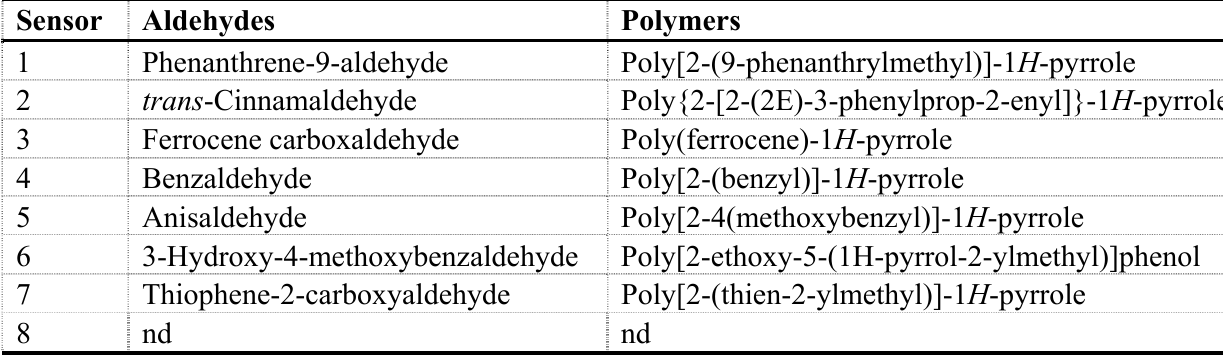
Table 2. Active matrix (polypirrole polymers) used to coat the quartz crystal microbalance sensors of LibraNose 2.2 e-nose